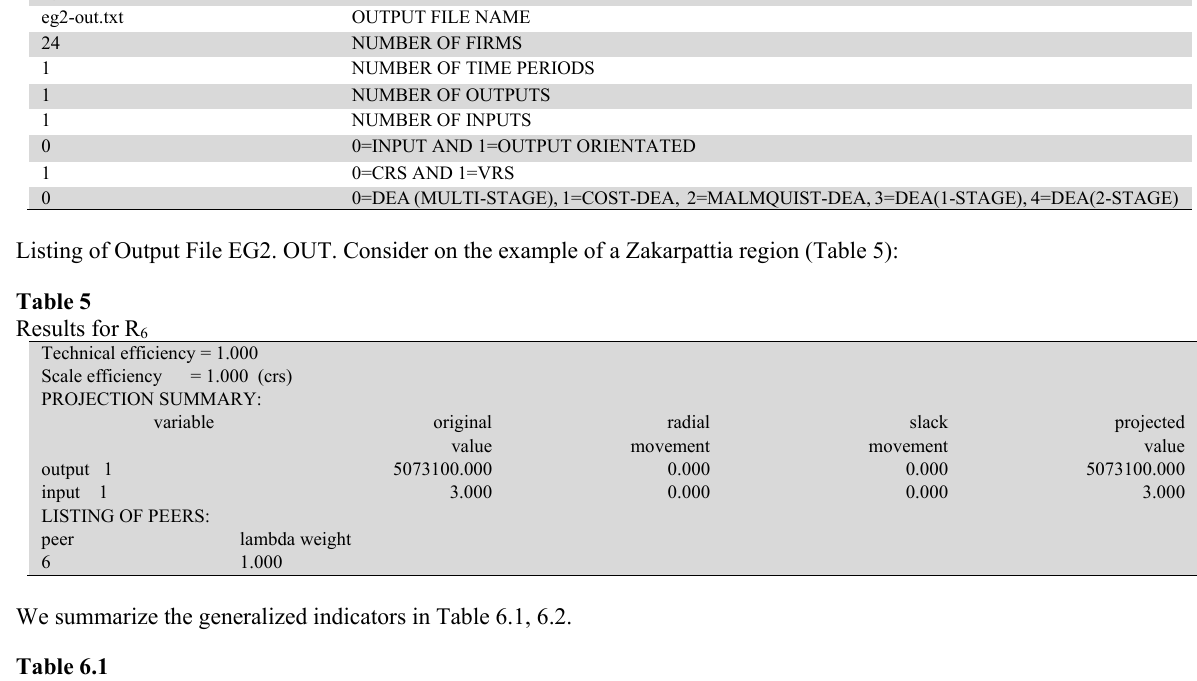
DEA efficiency scores for P 2 , P 3